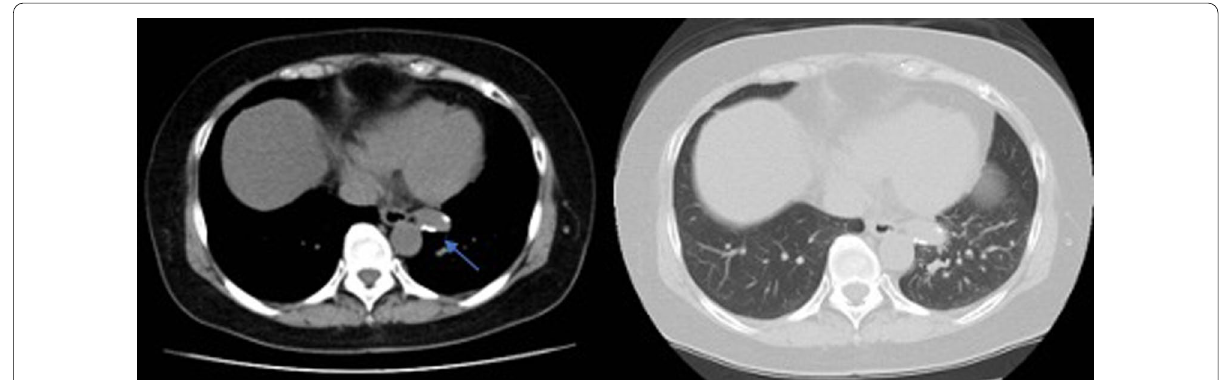
Fig. 1 CT of the chest showing the abnormal artery with calcification(arrow)